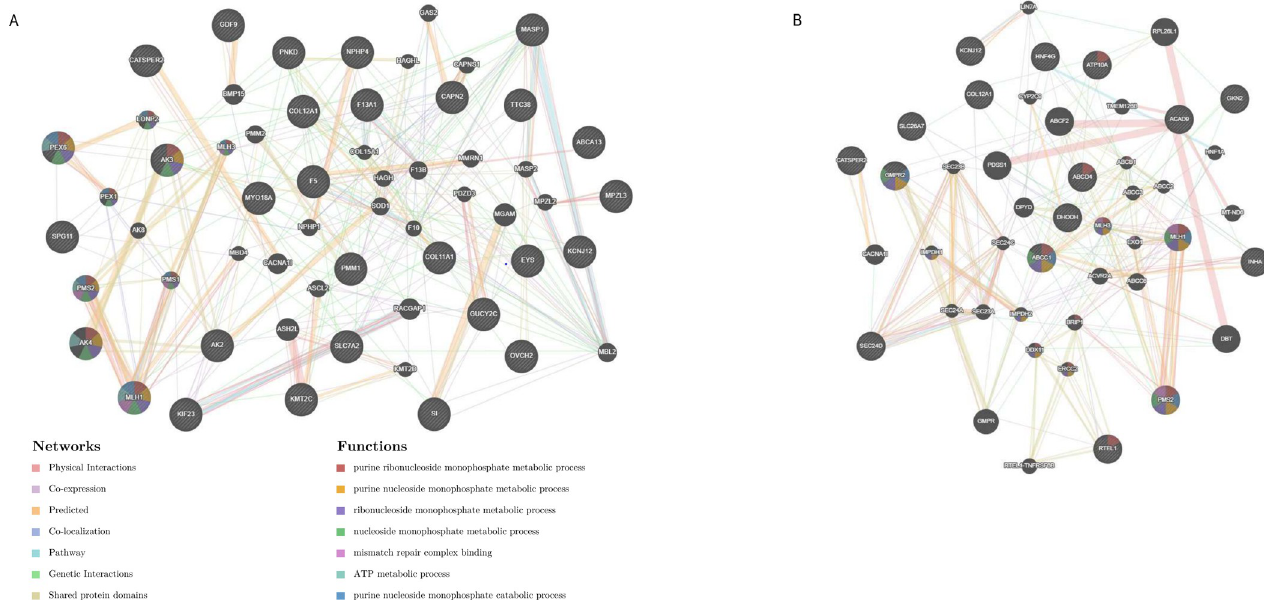
Fig 4. A: Gene-specific proportion of pathogenic SNPs across 20 ethnic groups, and Family A and B from 40 genes known to associate with tendon and ligament injury and B: Gene-specific SNPs minor allele frequencies across 20 ethnic groups from 40 genes known to associate with tendon and ligament injury.